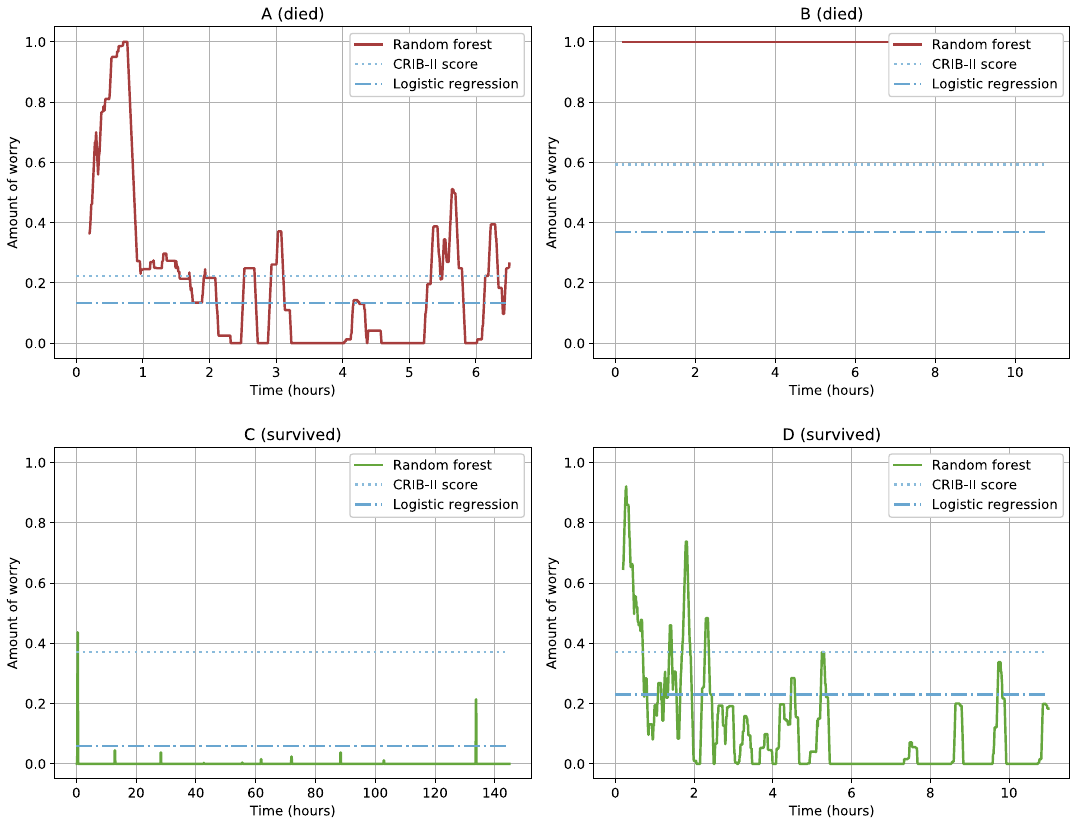
Figure 4. Per-timepoint random forest predictions over time for randomly selected infants. Per-timepoint forest model predictions plotted over time for four randomly selected infants (labelled A-D). Each graph plots the rolling average of predictions (per timepoint) over one hour. Values range between 0.0 (“don’t worry”) and 1.0 (“worry”) ( i.e. , higher values indicate that more “worry” predictions were made in the past hour). For comparison, the a priori CRIB-II score predictions (represented as a proportion of the maximum CRIB-II score, 27) and logistic regression probability estimates are also